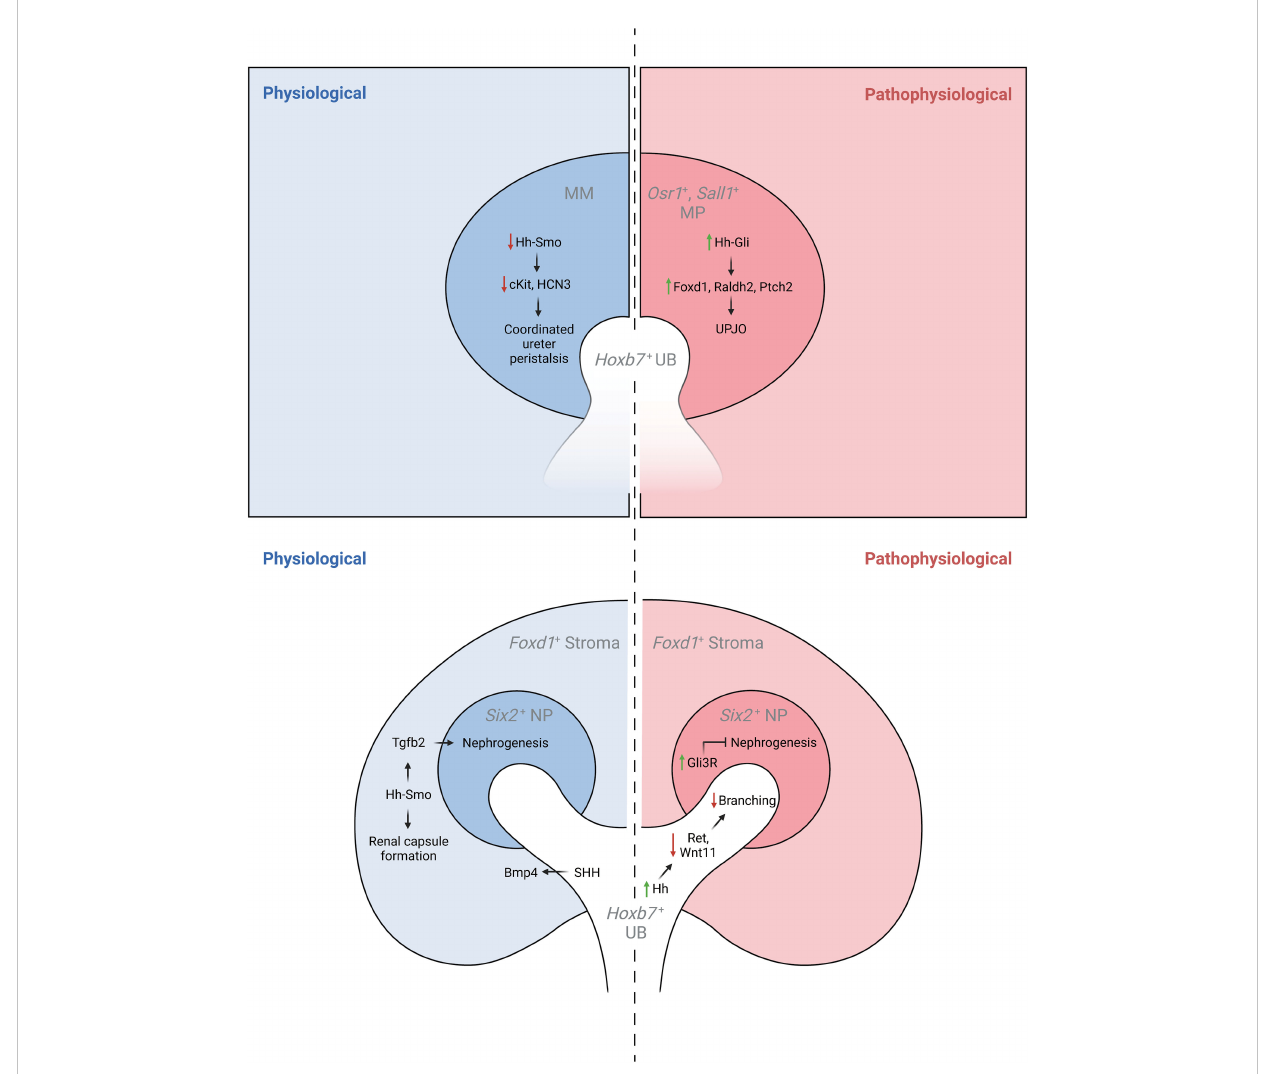
FIGURE 2 The physiological and pathophysiological roles of Hh signaling in speci fi c lineages of the developing kidney. MM, metanephric mesenchyme; MP, mesenchymal progenitors; UB, ureteric